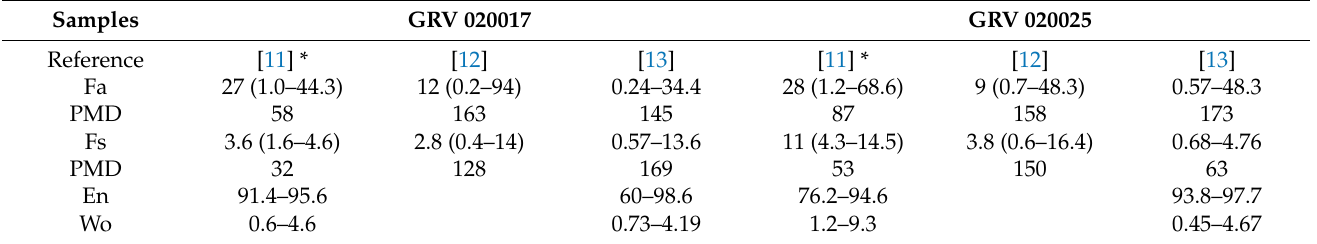
Table 3. Mineral composition of olivine and pyroxene in GRV 020017 and GRV